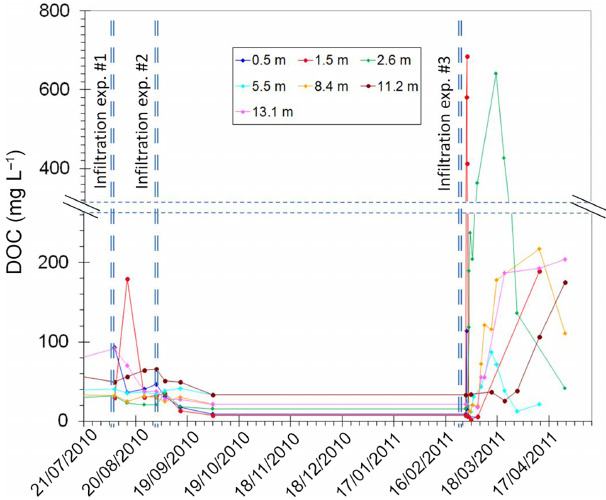
Figure 6. Variations in dissolved organic carbon (DOC) across the top 13m of the vadose zone following infiltration of water enriched with ethanol. Dates are given as day/month/year.